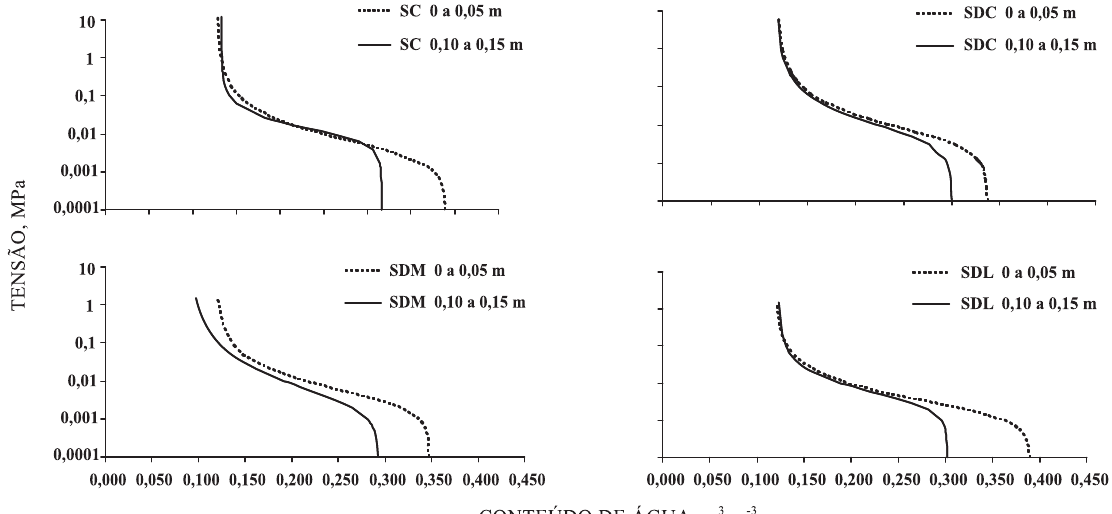
Figura 1. Curvas de retenção de água de um Latossolo Vermelho em sistemas